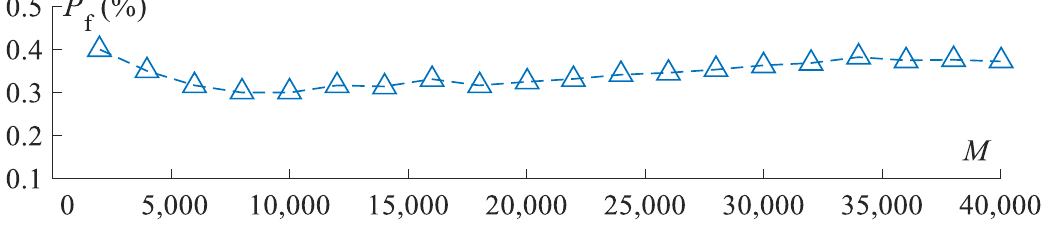
t = 3 h). Figure 9. System failure probabilities with different sample sizes ( t d = 3 h). d